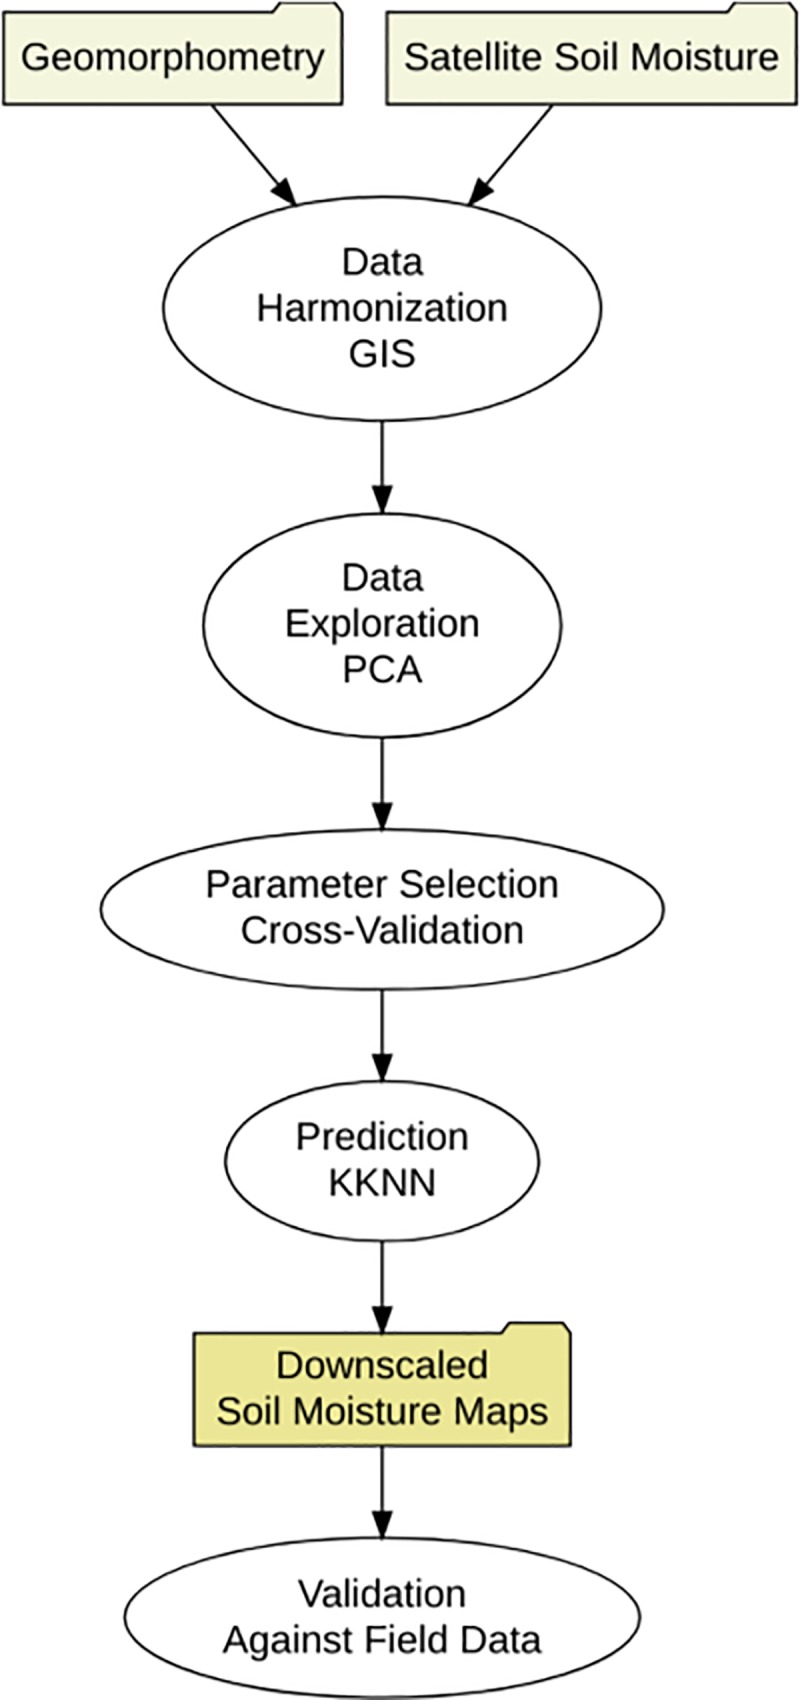
Soil moisture prediction framework.The folders are the inputs and outputs and the ovals are methods for data preparation (data bases harmonization), modeling (for prediction) and validation (for assessing the reliability of soil moisture maps). The field data from the North American Soil Moisture Database (NASMD) was only used for validation purposes (i.e., not for training the model).